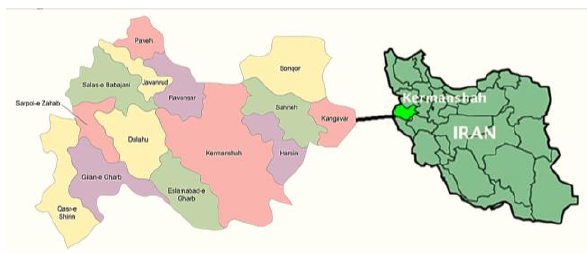
Figure 1. Sarpol-Zahab-Iran